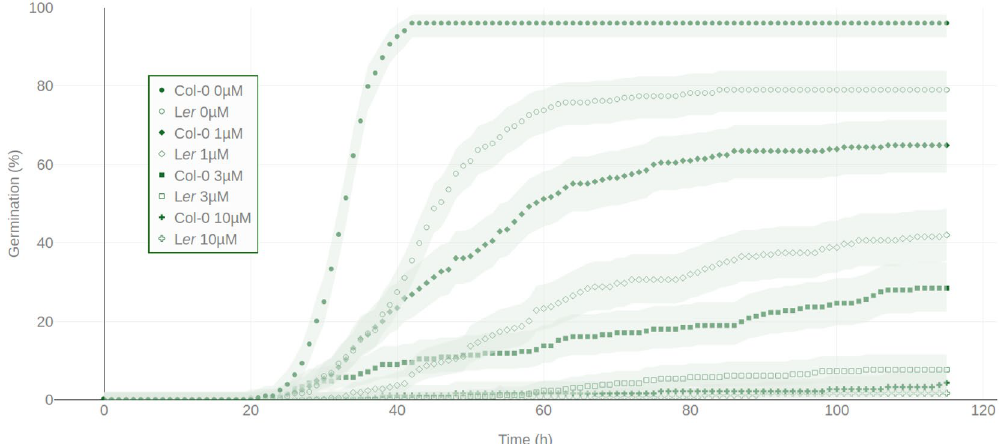
Figure 5. Comparison of ABA dose responses for germination inhibition of L er and Col-0 accessions. Germination kinetics of L er (diamonds and crosses) and Col-0 (dots and squares) were monitored in water (filled dots and diamonds) condition and in 1 µ M (empty dots and diamonds), 3 µ M (filled squares and crosses) or 10 µ M (empty square and crosses) ABA. Each germination curve scored by a symbol in the graph is an average ± standard error of a representative experiment (12 blocks of replicates). Shaded area around each curve represents the 90% confidence intervals matching Fisher Exact test as described in 50 . Except for ABA at 10 µ M that completely inhibited seed germination (c.f. Table 3), L er germination kinetics exhibited a significant higher ABA sensitivity compared to Col-0.